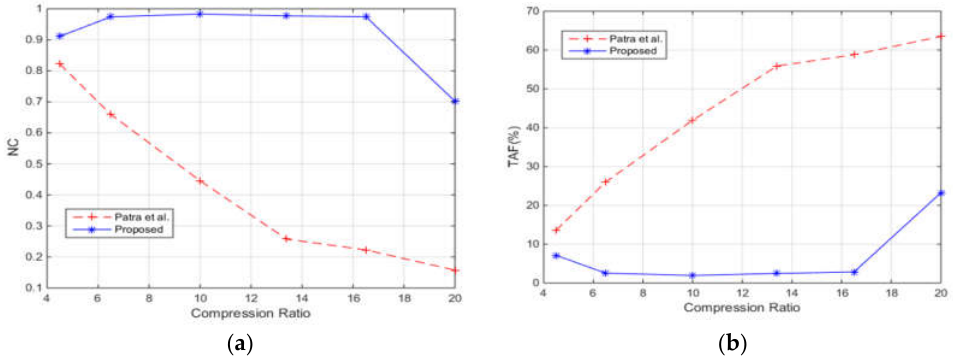
Figure 7. PSNR vs. Compression ratio on ( a ) Mandrill; ( b ) Lena, and; ( c ) Boat images. 4.2. Robustness after Different Attacks Table 4 shows the quality of the extracted watermark after some conventional attacks such as cropping, addition of noise, sharpening, inversion, histogram equalization and auto contrast operations. It observed that the proposed method could able to extract a good quality watermark in all cases. Image inversion and auto contrast operation give better quality watermark with an NC value close to 1. Acceptable quality watermark is also obtained in cropping attack, masking face with a black box, cropping a quarter part of the image on any direction, noise and sharpen operations. Similar acceptable quality watermark can also be obtained by masking the image with a white box. The PSNR values indicate the extracted quality of the watermarked images. PSNR values of 35–36 dB indicate good quality watermarked images are also obtained in most of the attacks. Table 4. Simulation results of common image processing attacks.